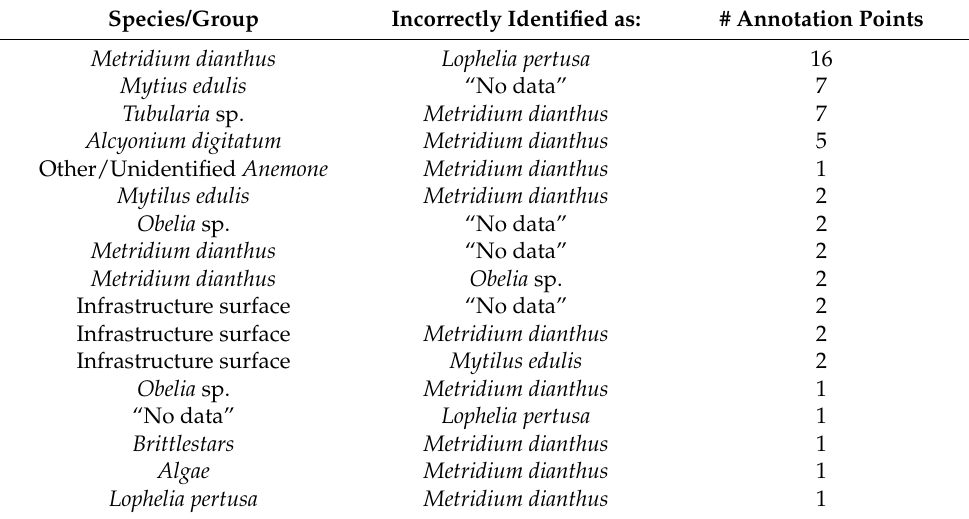
Table 3. Number of annotation for species/labels identified incorrectly by classifier alongside the correct species/label. [#: number